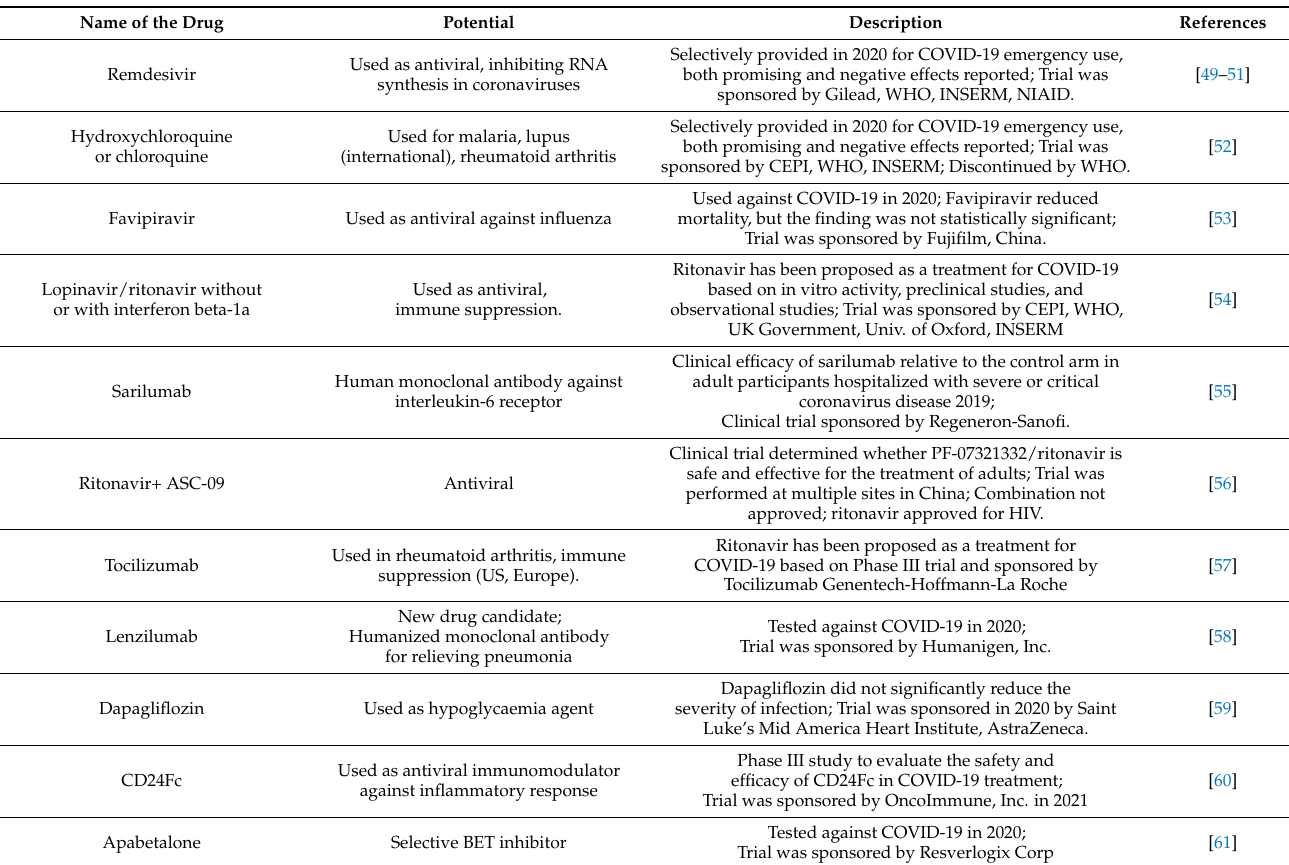
Table 6. List of drugs used in SARS-CoV-2